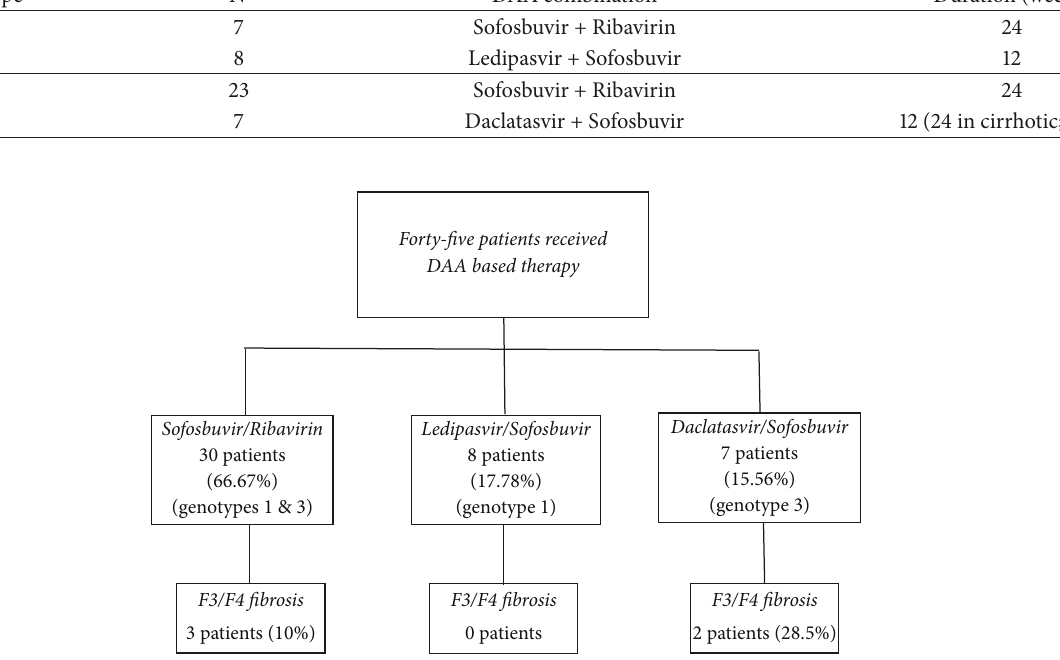
Figure 1: Study population: DAA regimen stratification of study